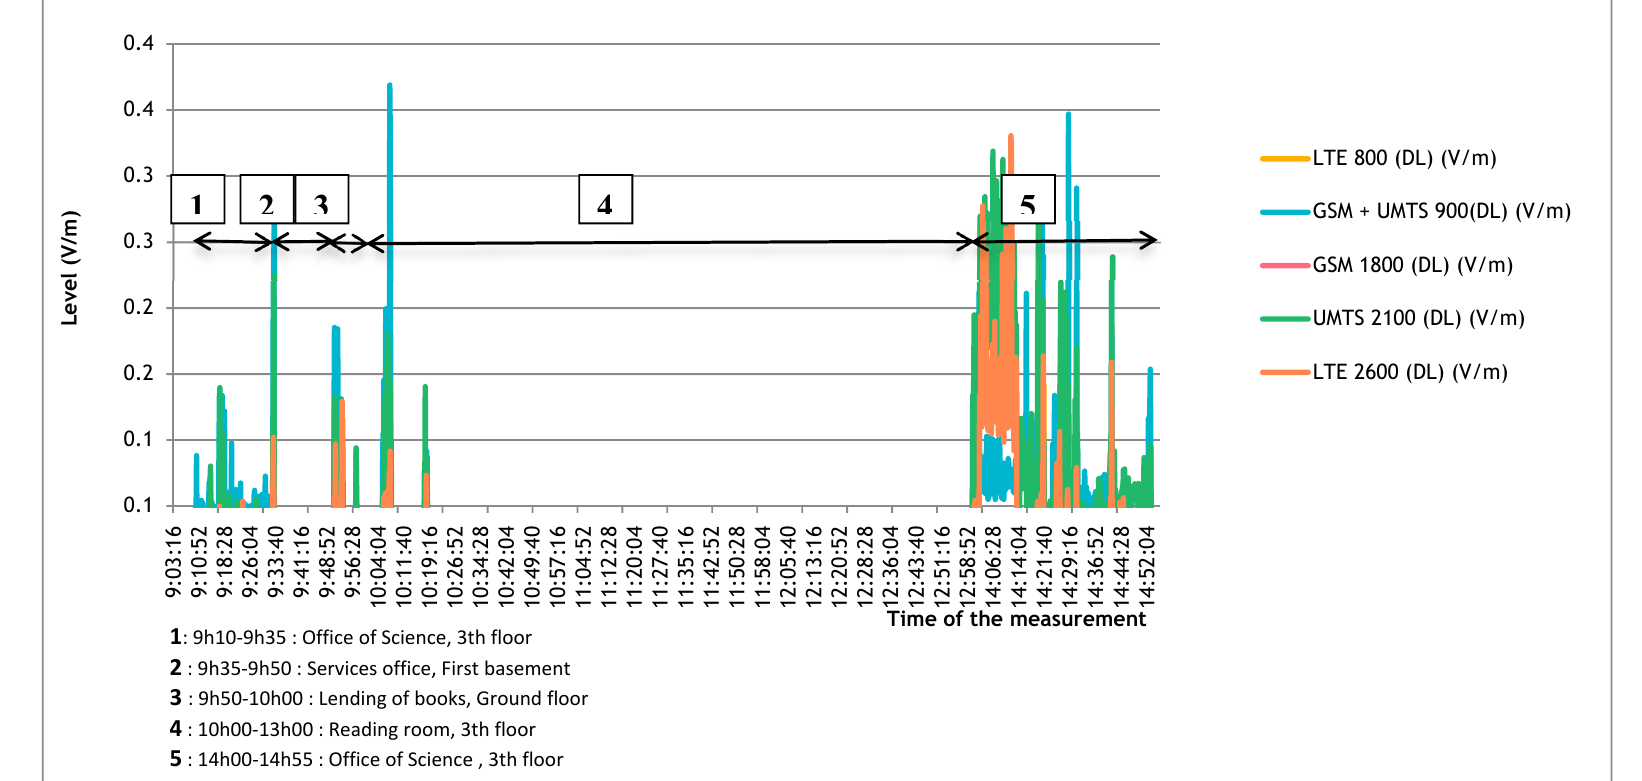
Figure 3. Example of individual exposure samples according to the geographical situation and the workplace.